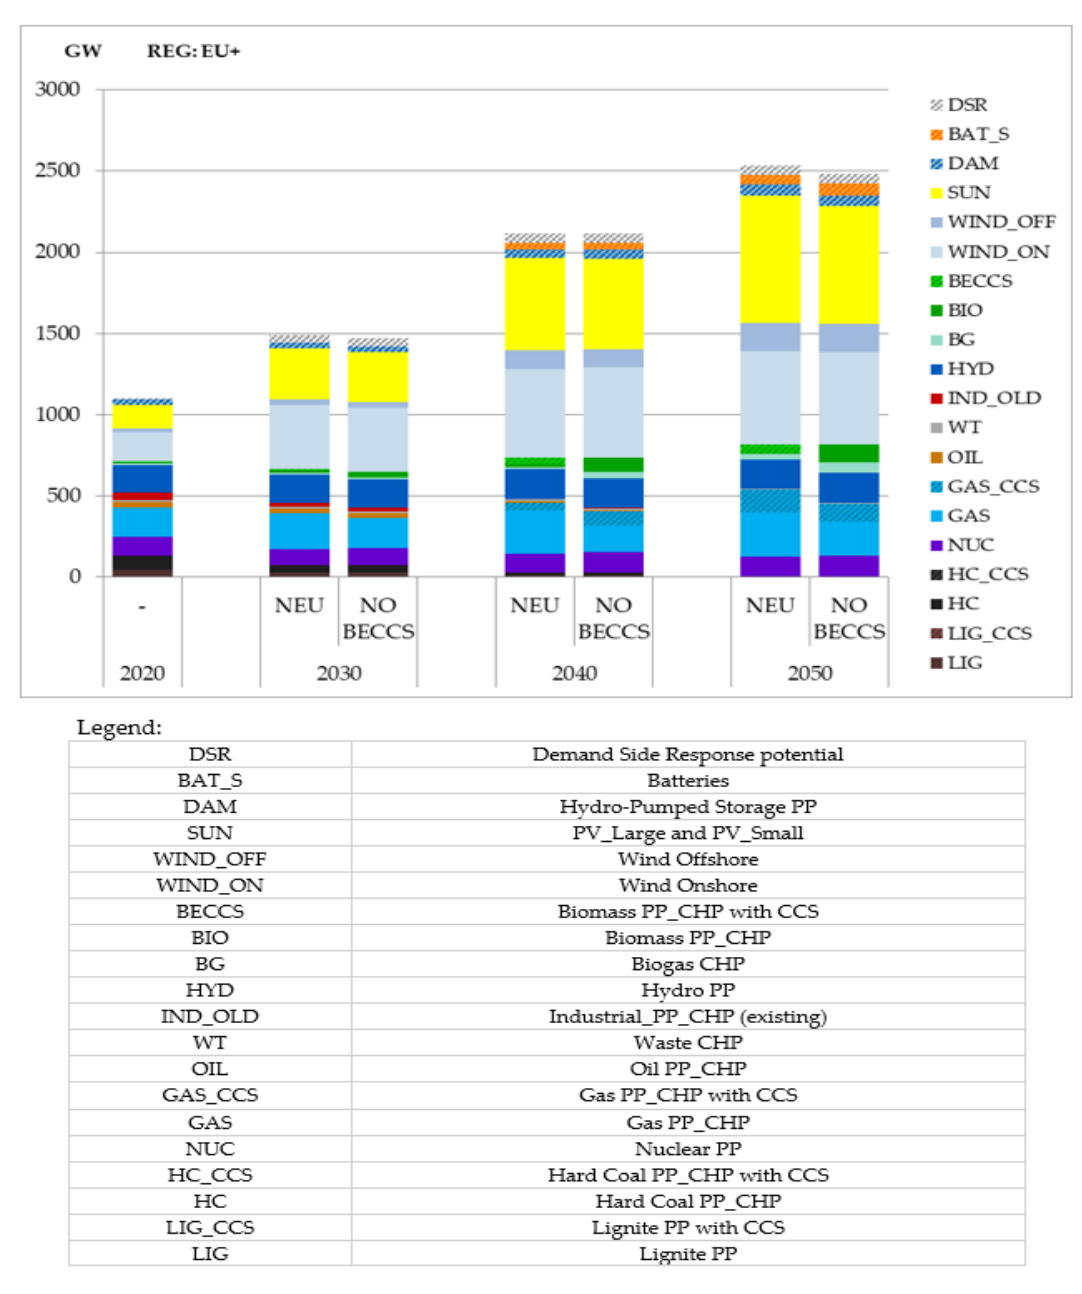
Figure 4. Installed electricity generation capacity by fuels and technologies in the EU+ (in GW). Source: own calculations based on MEESA model results.